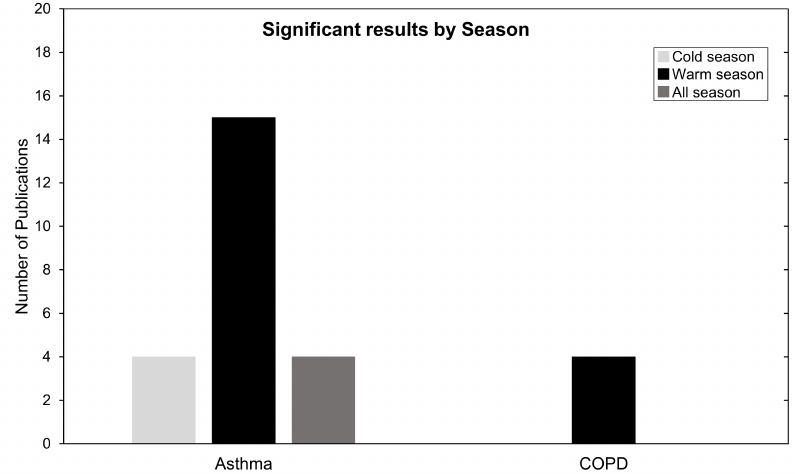
Figure 8. Number of publications categorized by season. Warm season (April until September) and cold season (October until